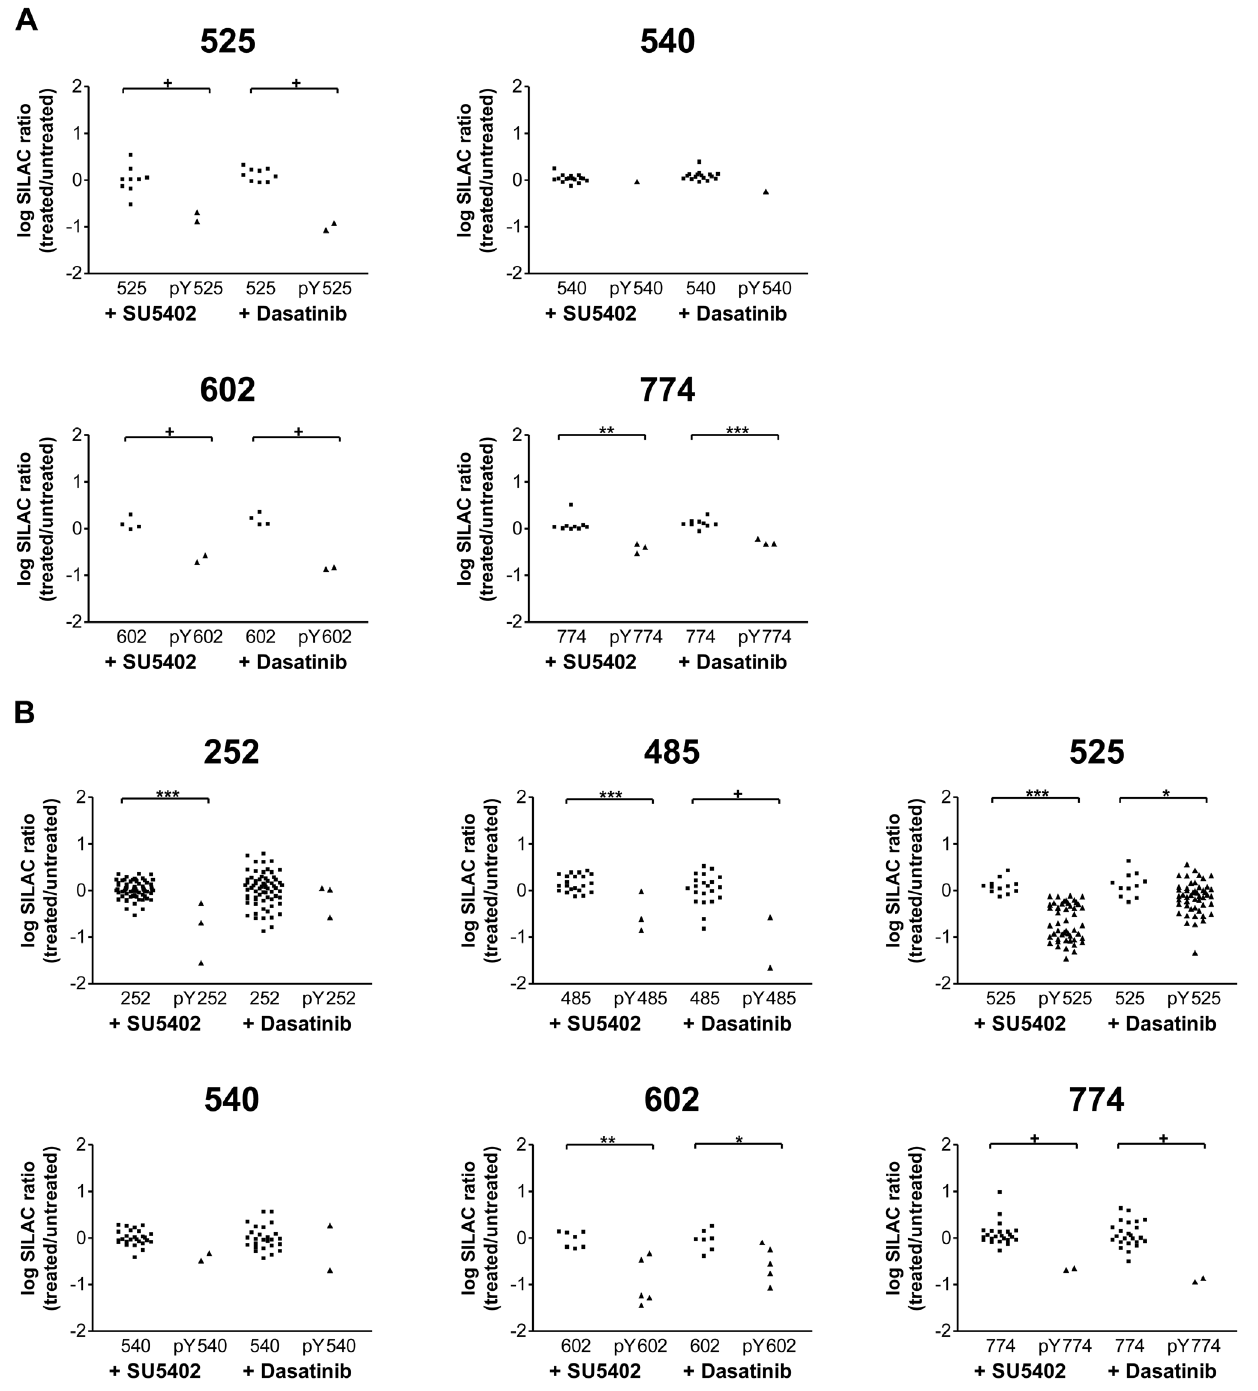
Figure 3. Differential regulation of tyrosine phosphorylation on Eps8. Heavy, medium and light SILAC labelled HEK 293T cells were treated with either 25 nM dasatinib, 20 m M SU5402, or no inhibitor, prior to FGF2 stimulation (20 ng/ml; 15 min). Myc-Eps8 was immunoprecipitated and the resulting sample was run on an SDS-PAGE gel and, following in-gel trypsin digestion and phophopeptide enrichment, analysed by mass spectrometry. Each graph represents specific residues on Eps8 as indicated. Each data point represents a single peptide identification. P values were calculated by an unpaired t-test (0.01–0.05= *; 0.001–0.01= **; , 0.001= ***). + , the median of the ratios is , the cut-off value of 0.57 and is deemed significantly changed (see Method S1). A) Experiment was carried out in the absence of sodium pervanadate. B) Experiment was carried out in the presence of 2 mM sodium pervanvadate.